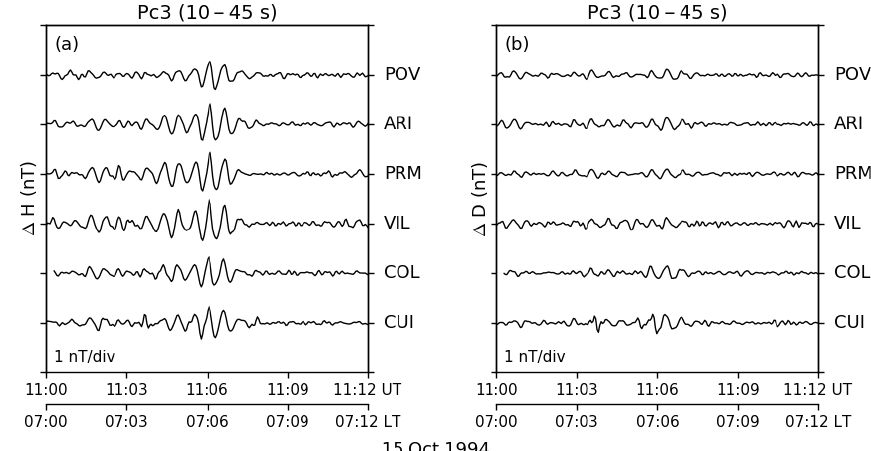
Figure 9. Band-pass-filtered geomagnetic variations ( H and D components) in the Pc3 interval, shortly after sunrise on 15 October 1994.